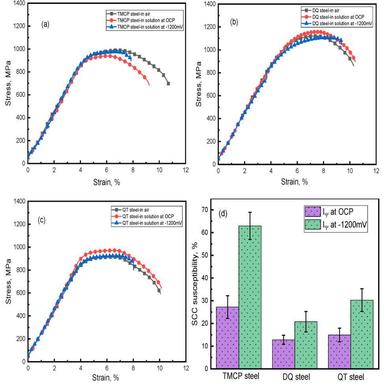
Stress-strain curves of Ni-advanced steels prepared with different processes in the simulated solution (a) TMCP steel, (b) DQ steel, (c) QT steel (d) SCC susceptibility.